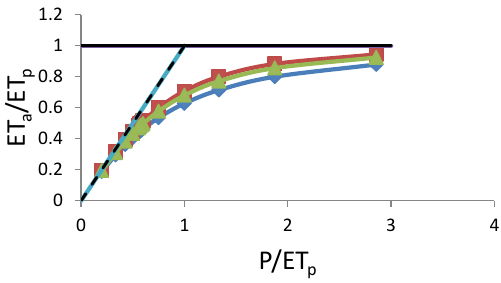
Figure 3. A representation of the Budyko formulation using the Choudhury–Yang formulation with three different values of n (from 1.5 to 2.0). Redrawn from Leaney et al.